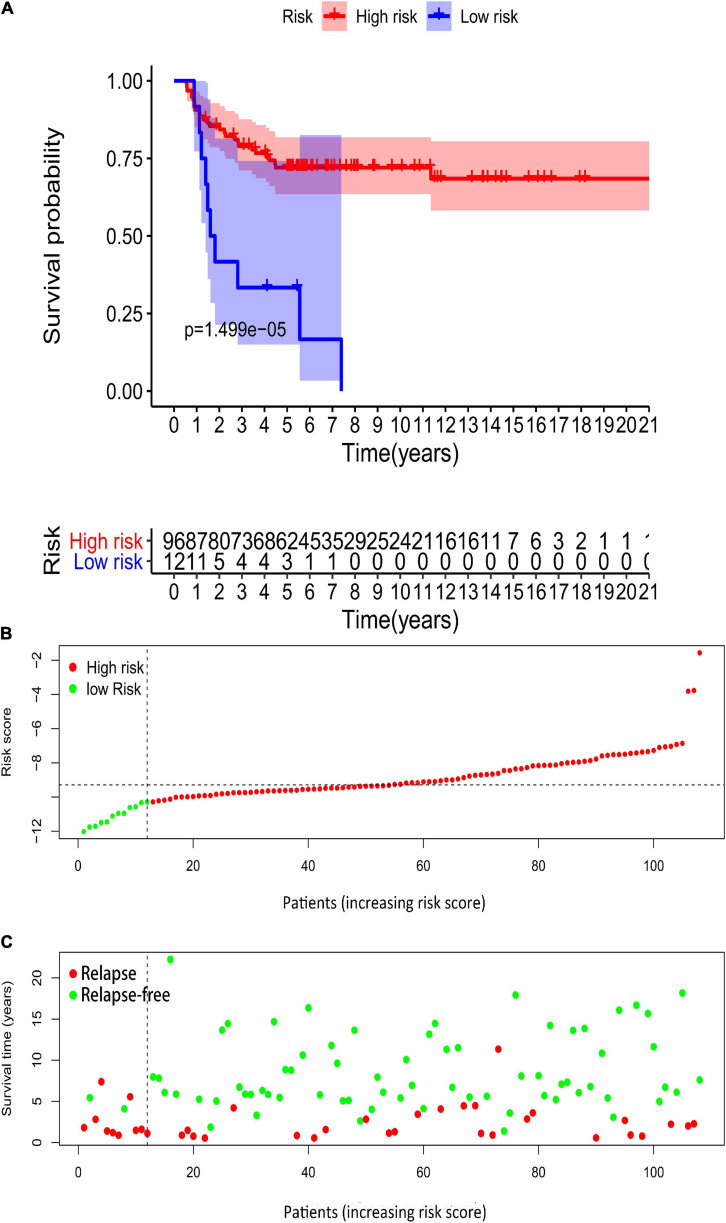
Validation of the prognostic value of the risk model in GSE3218 and GSE10783 datasets. (A) Kaplan–Meier survival curve analysis of OS in high-risk score and low-risk score TGCT patients in GSE3218 and GSE10783 datasets, marked as red line and blue line separately. (B,C) Risk score, distribution of survival status between the high-risk and low-risk groups, and expression heat maps of six RBPs. OS, overall survival; TGCT, Testicular germ cell tumors; TCGA, The Cancer Genome Atlas; RBPs, RNA-binding proteins.